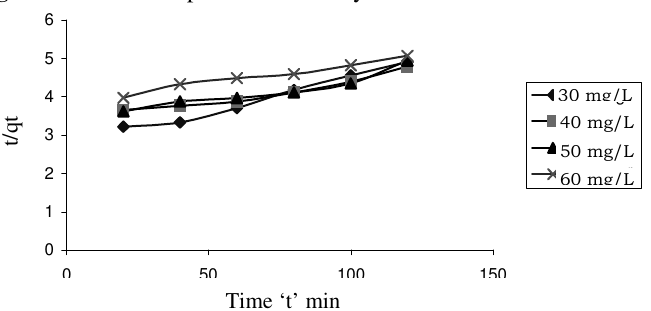
Figure 9. Pseudo-second-order plot of adsorption of Grey BL dye concentration variation.